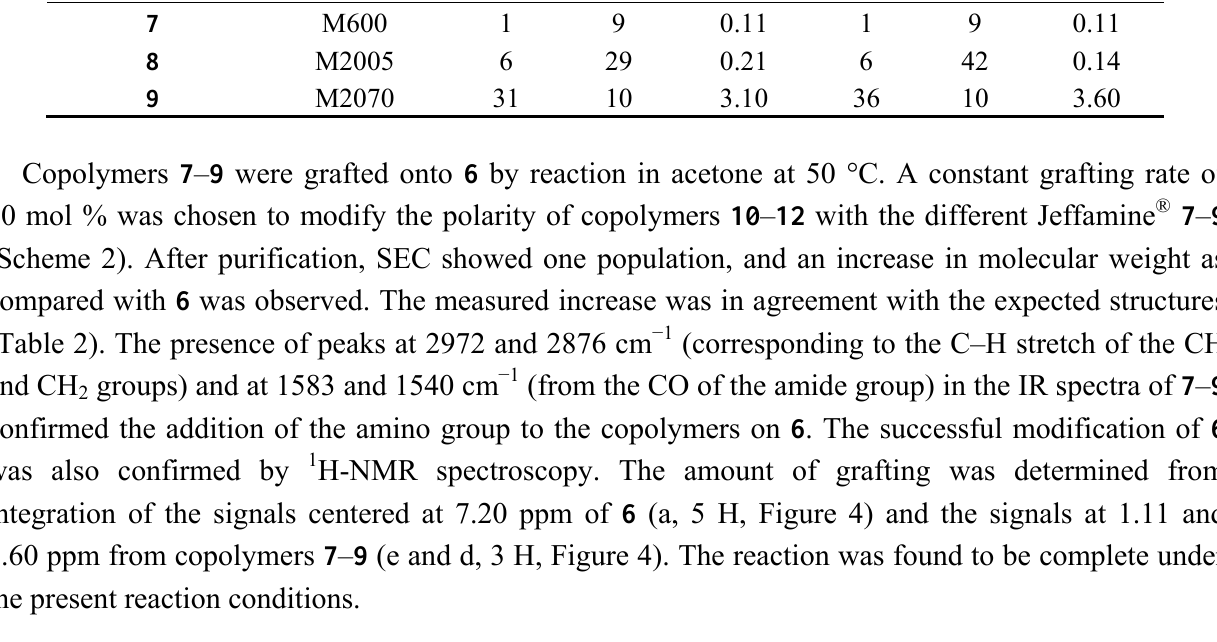
Table 1. Composition of the molar ratio of ethylene oxide (EO) and propylene oxide (PO) in copolymers 7 – 9 , as indicated from the supplier and measured by 1 H-NMR spectroscopy. From supplier Measured by NMR Copolymer Jeffamine ® n EO n PO EO/PO n EO